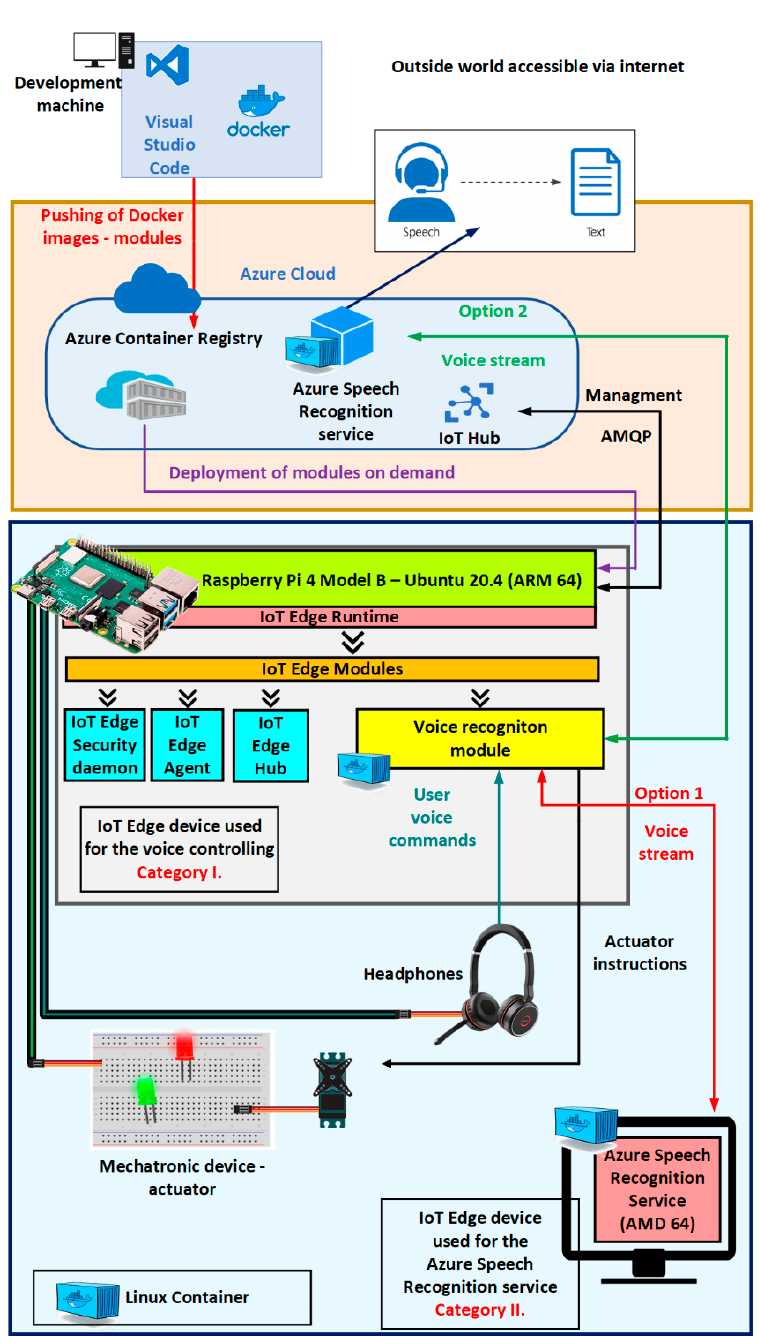
Figure 3. The entire architecture of the controlling of the actuator using voice commands. In Figure 4, it is possible to see the sequence diagram of the initialization of the speech- controlled solution. The initialization of the voice-controlled actuator and the microphone